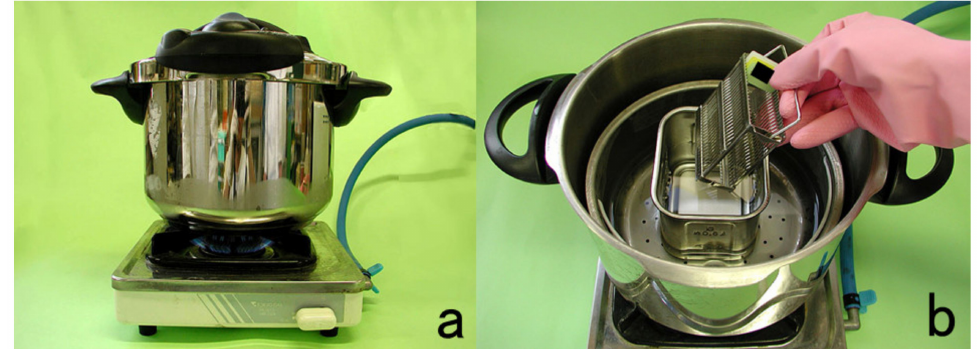
Figure 33. Recommendation of a pot typically used in French cuisine for use as a pressure pan ( a , b ). The pressure pan made by T-Fal (Rumilly, Haute-Savoie, France) is easy to handle and use for HIER in a diagnostic pathology